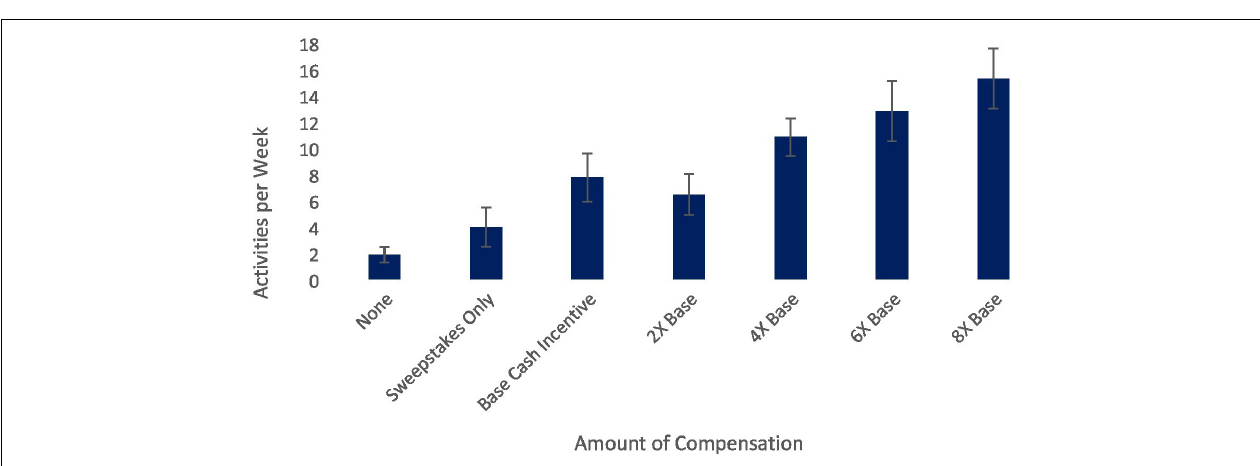
FIGURE 1 | Relationship between cash incentive level and percentage of active days on a digital mental health platform.